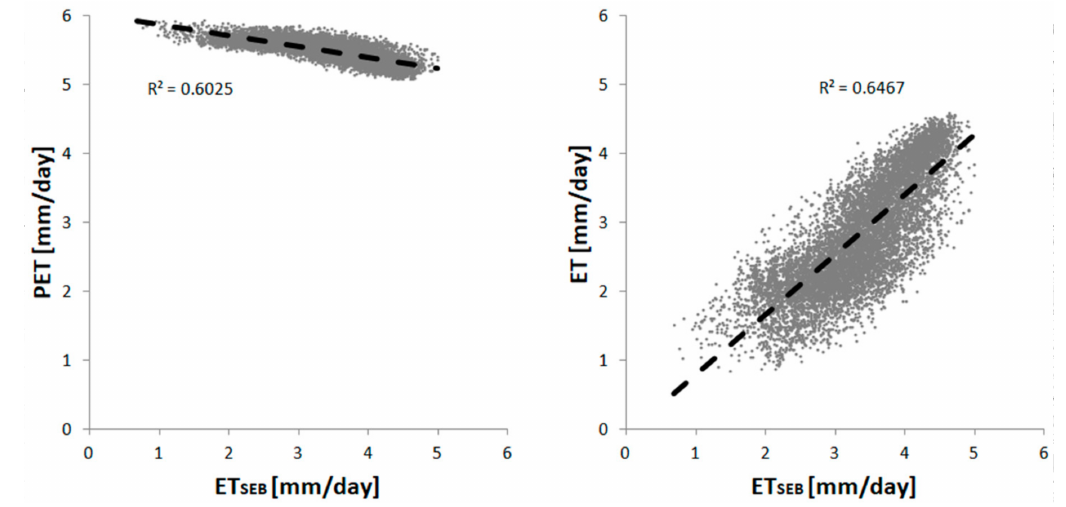
Figure 6. Cell-based comparison of the SEBAL ET raster values (on 6th June 2000) to PET ( left ) and ET based on proposed concept ( right